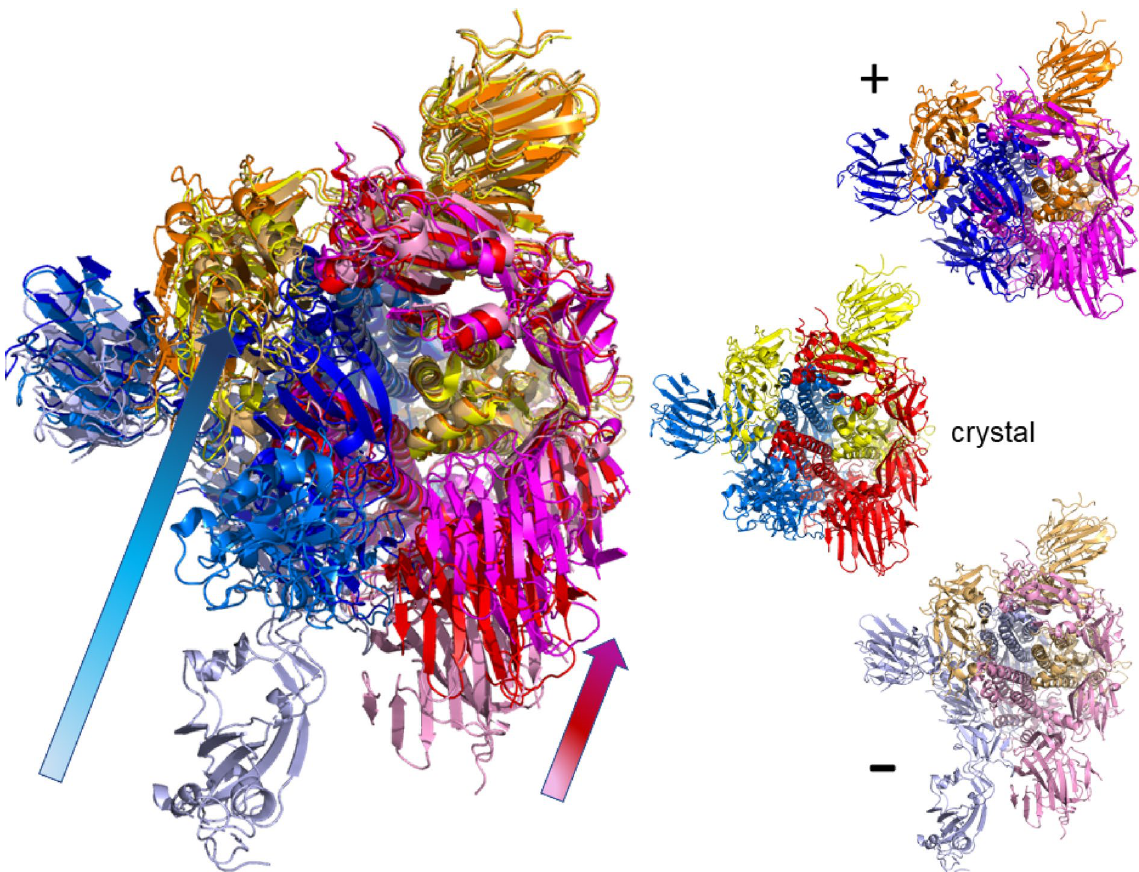
Figure 7. Possible motion along mode m 7 at E cut = 1 kcal/mol in the open spike ecto domain (6vyb) 9 when in view from the top. Colors for the superimposed structure are chosen identical to Figs. 5 and 6. As in Fig. 3, the arrows indicate the range of motion for chain B (blue shades) and also for chain C (reds). The initial (crystal) structure as well as the extremes ( + , –) along m 7 in the same colors as in the superimposed structure are shown in the three smaller